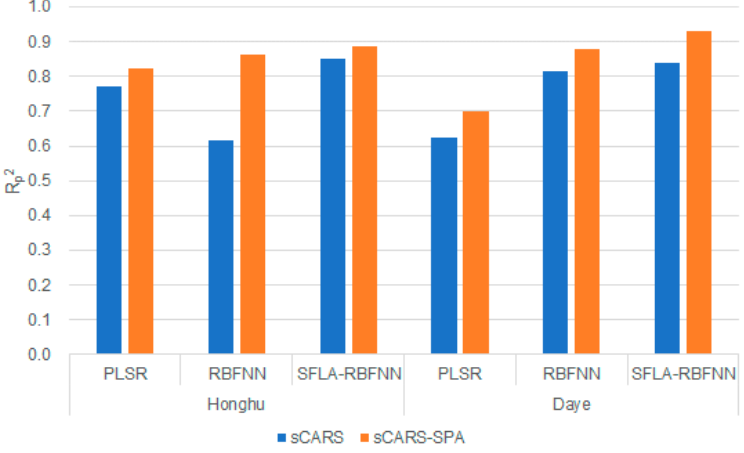
Figure 8. Comparison of the sCARS and sCARS-SPA in R 2 p . Figure 7. Comparison of the sCARS and sCARS-SPA in 𝑅 (cid:3043)(cid:2870) .